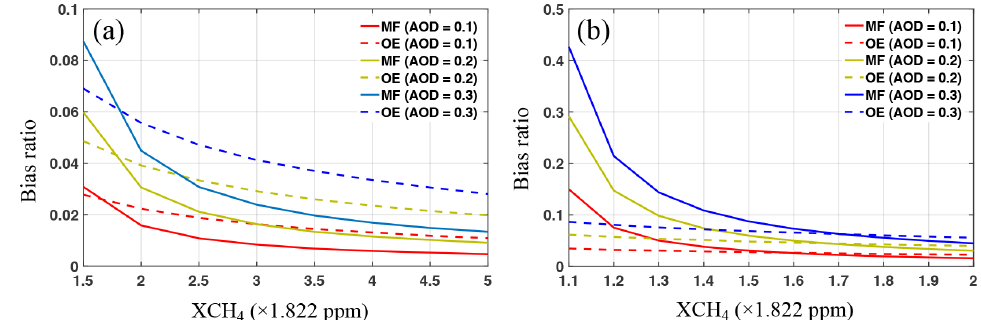
Figure 10. (a) Bias ratio as a function of CH 4 concentration for the two retrieval techniques, where the XCH 4 ranges from 1.5 to 5 ( × 1 . 822ppm). (b) Same as (a) , but for XCH 4 ranging from 1.1 to 2 ( × 1 . 822ppm). Surface albedo is set to 0.3 for all cases; results for the MF and OE methods are shown by solid and dashed lines,